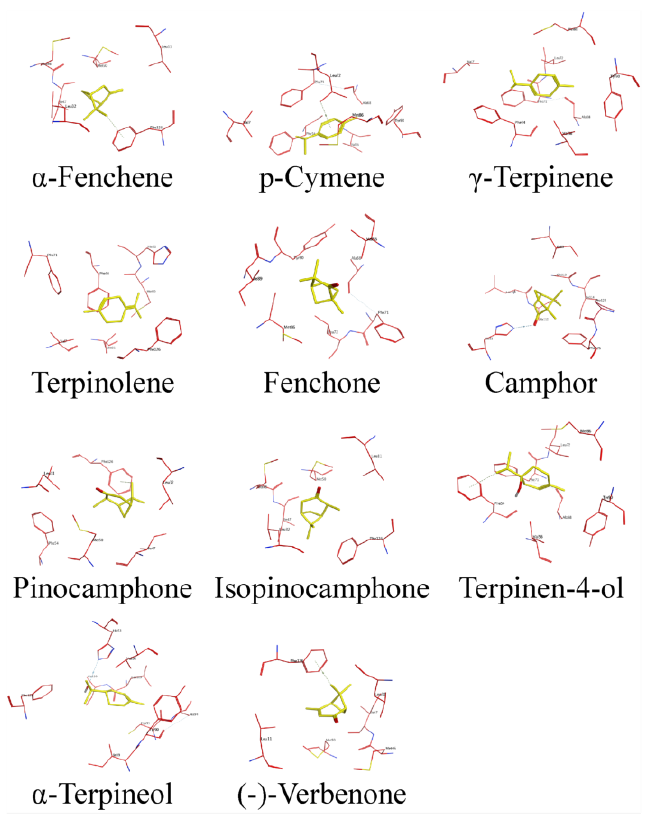
Figure 8. Docking conformation of HIPVs into the putative binding pocket of DhelOBP4. Table 4. The key residues of DhelOBP4 interacted with HIPVs within 4 Å .